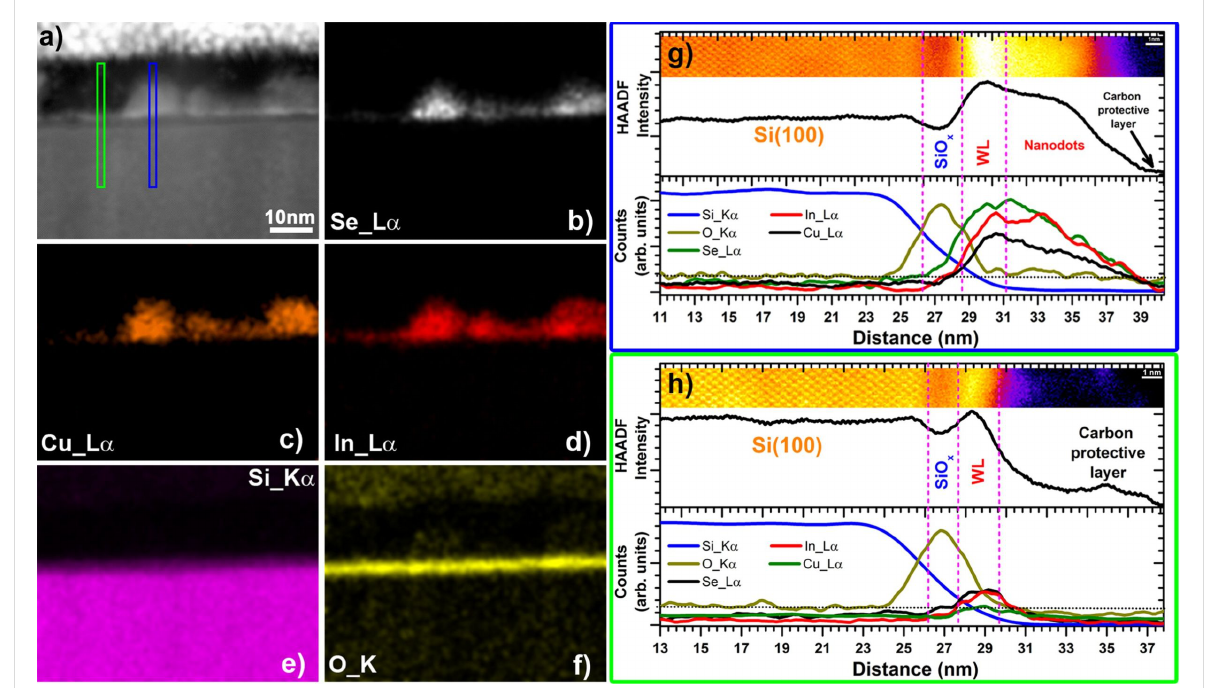
Figure 3: Chemical analysis of the sample grown at 530 °C. (a) Low-resolution cross-section STEM HAADF image of a region of the 530 °C sample studied by EDS. (b–f) EDS mapping of Se, Cu, In, Si, and O. (g) EDS line profile across a nanodot (blue rectangle in (a)). (h) EDS line profile across the WL (green rectangle in